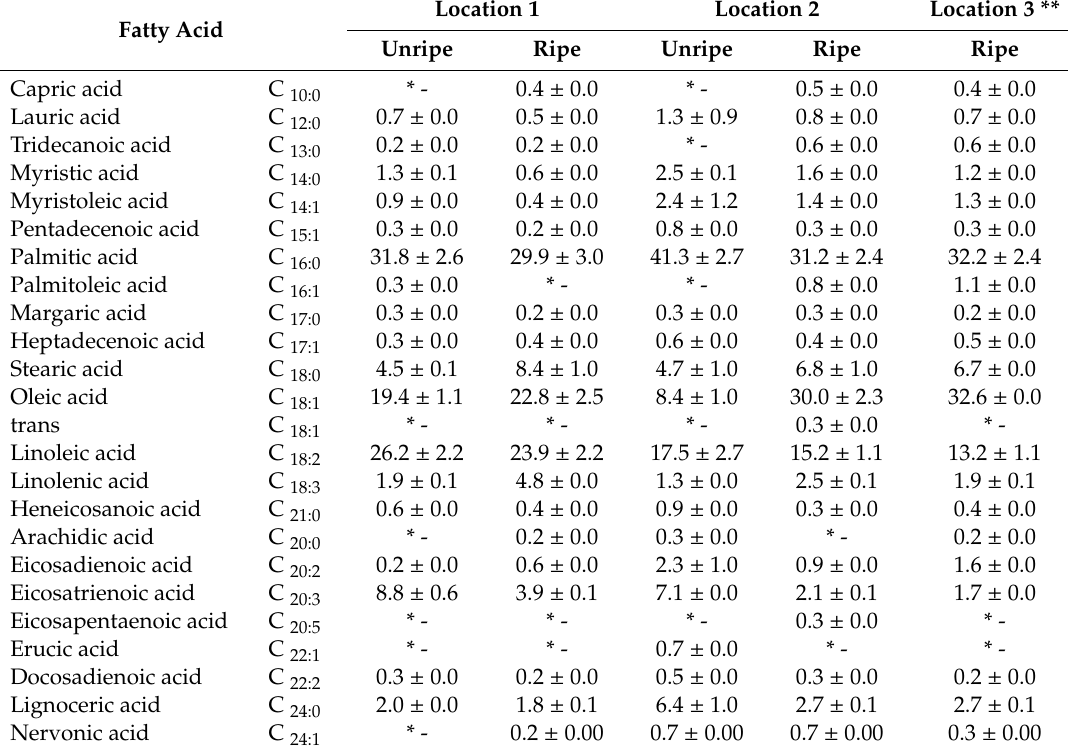
Table 2. Fatty acid composition of the lipid fraction of J. excelsa unripe and ripe galbuli from the three collection sites in Bulgaria (mean ± SD), %.